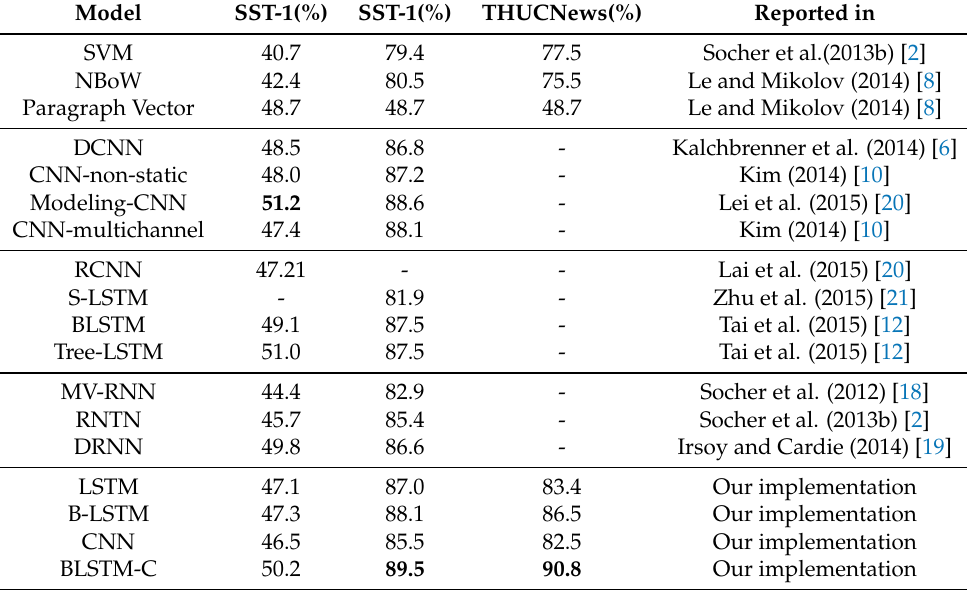
Table 1. Comparison with baseline models on Stanford Sentiment Treebank and